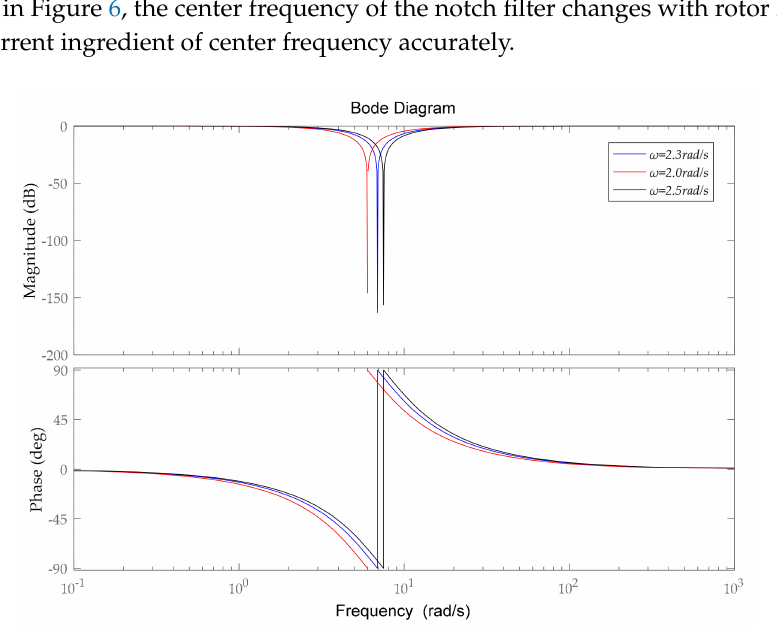
Figure 6. Bode diagram of notch